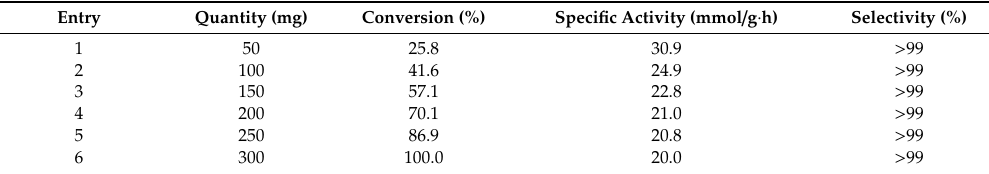
Table 4. Catalyst quantity optimization.